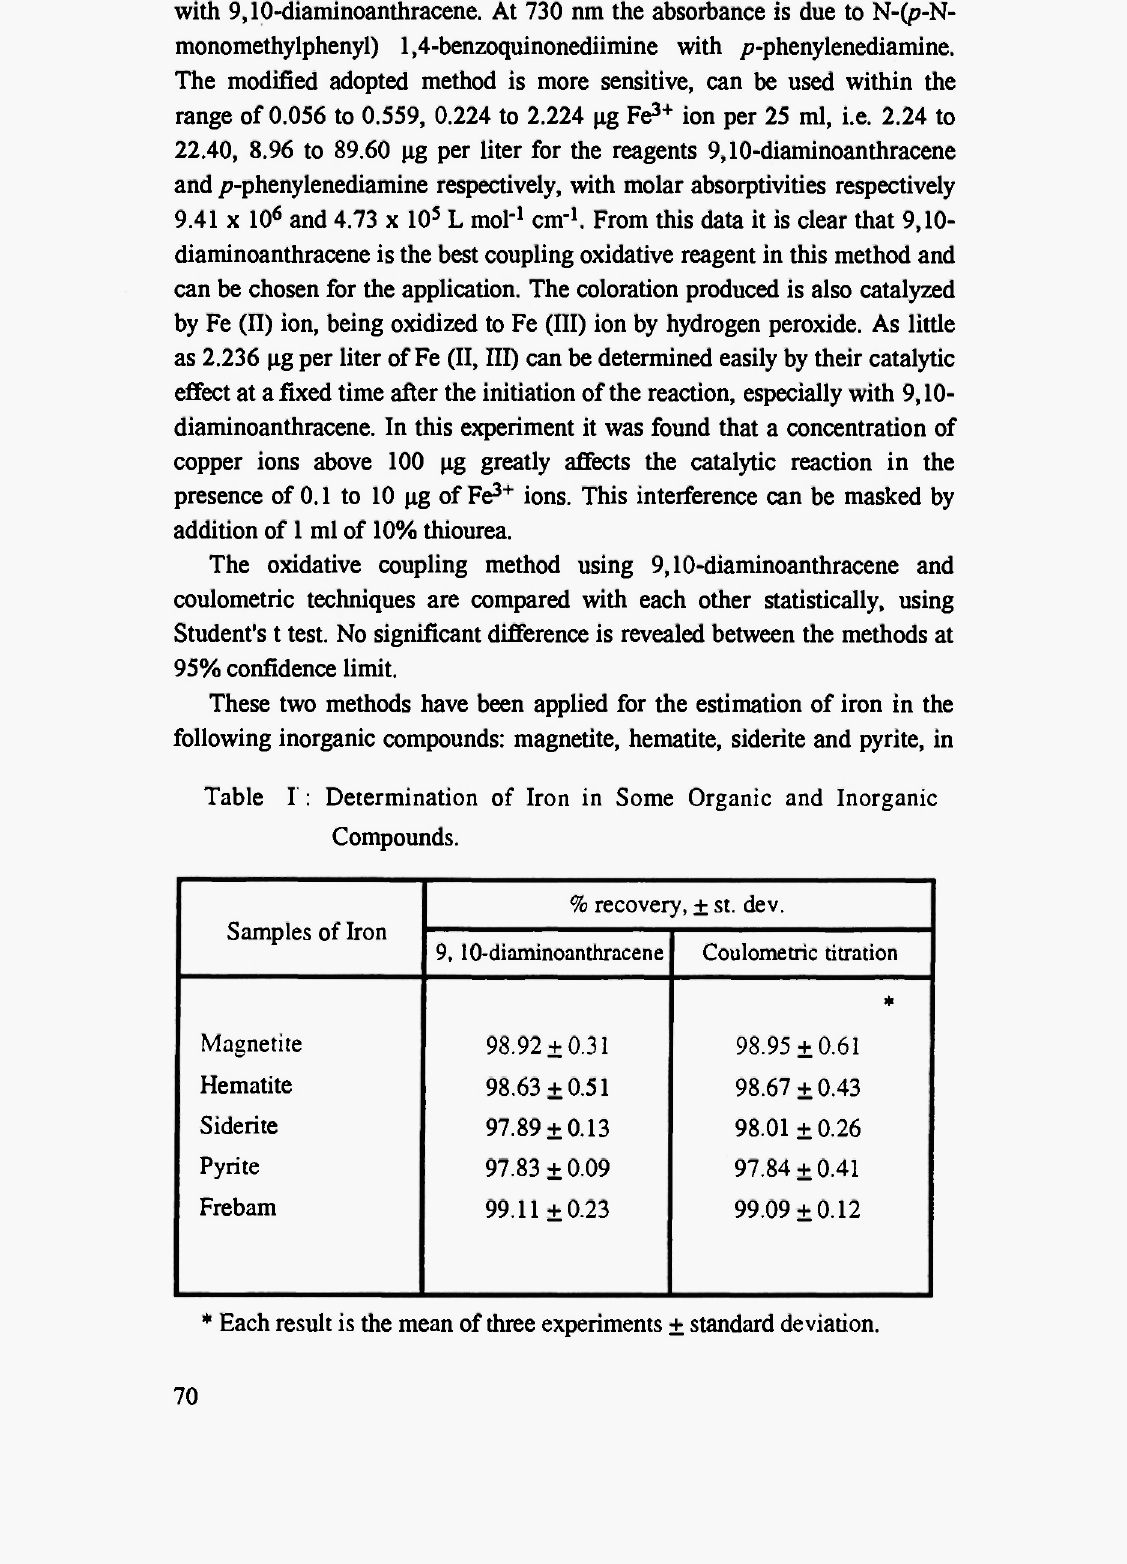
I : Determination of Iron in Some Organic and Inorganic Compounds. % recovery, ± st. Samples of Iron